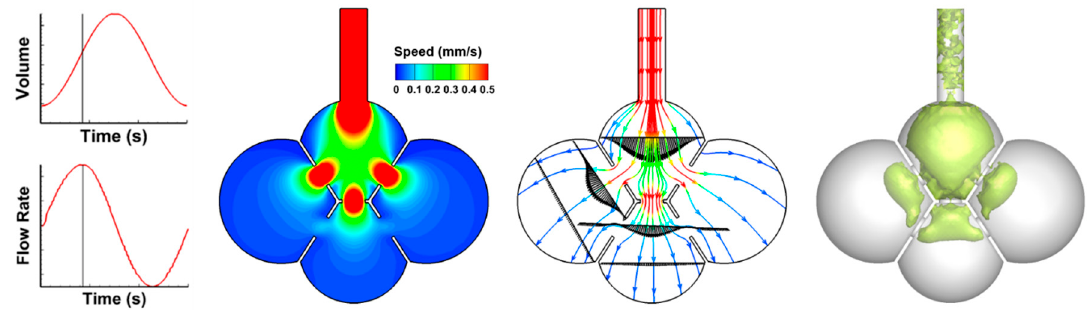
Figure 2. Airflow field in the 40-µm-pore alveolar model at the peak inhalation in terms of velocity contour ( left ), steam traces ( middle ), and coherent vortex structures ( right ).